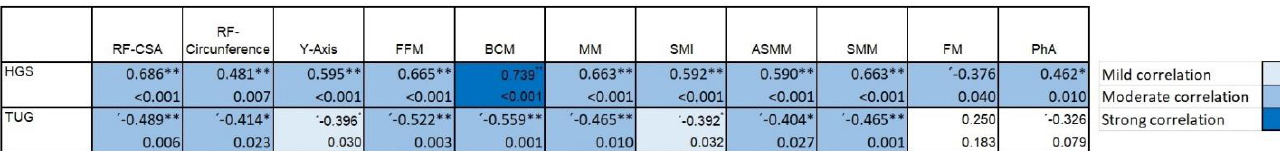
Figure 5. Correlation of the body composition techniques (bioelectrical and ultrasound measure- ments) and functional aspects (HGS and TUG) in post-critical COVID-19 outpatients. In the heat map, the lightest blue represents a correlation coefficient of less than 0.39, and the darkest blue color represents a correlation coefficient of 0.7; the larger the correlation coefficient, the darker the corre- sponding color. * p < 0.05; ** p < 0.01.